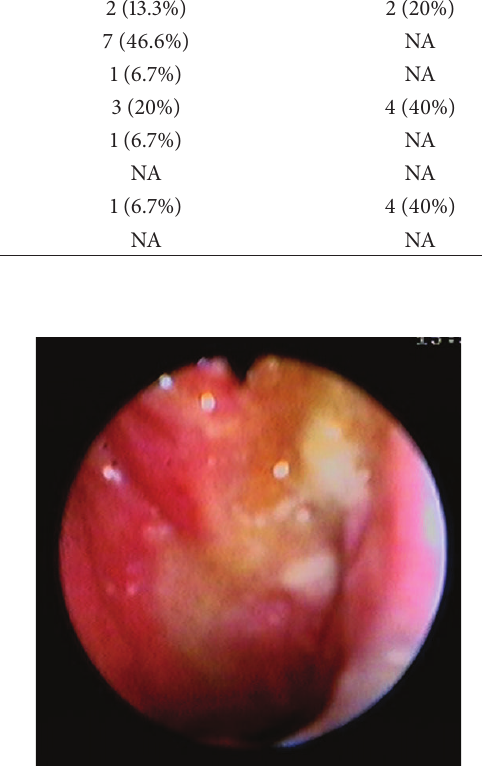
Figure 1: A 32-year-old woman, nasopharyngeal examination showsirregularrednessmucosaandwhitepatchcoversthenasopha- ryngeal